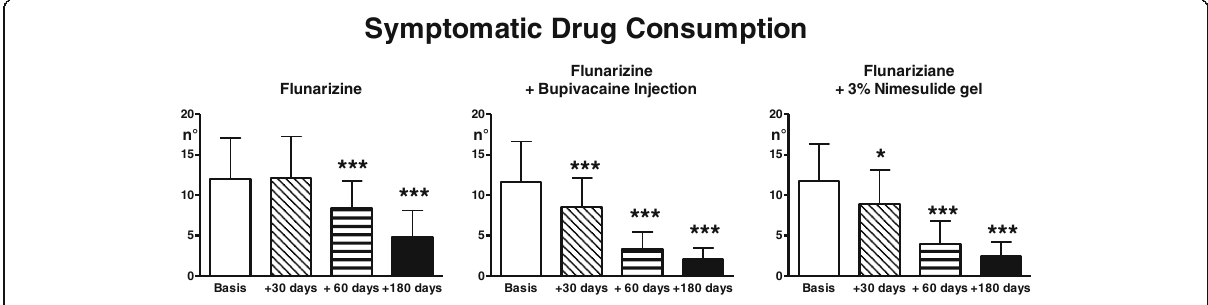
Fig. 2 Symptomatic drug consumption for migraine attacks. Legend as for Fig. 1